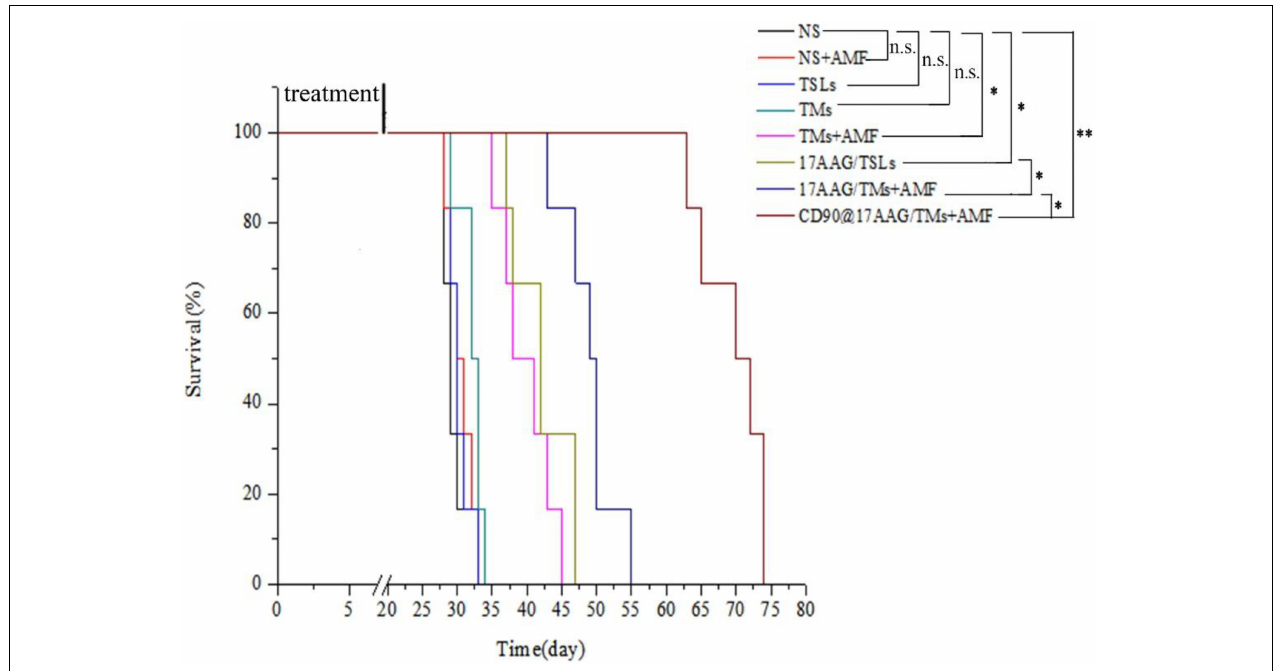
FIGURE 5 | Kaplan–Meier survival curve of CD90 + LCSC-bearing mice in different groups. n = 6 mice per group. Data are the mean ± SD. ∗ p < 0.05, ∗∗ p < 0.01.